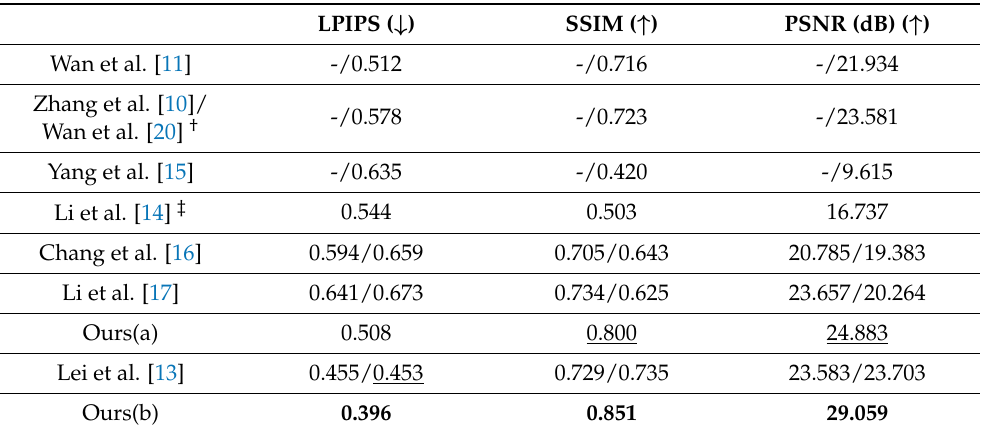
Table 2. Quantitative evaluations for transmission removal using three different error metrics of LPIPS, SSIM, and PSNR. (The best and second-best results are shown in bold and underlined, respectively.)